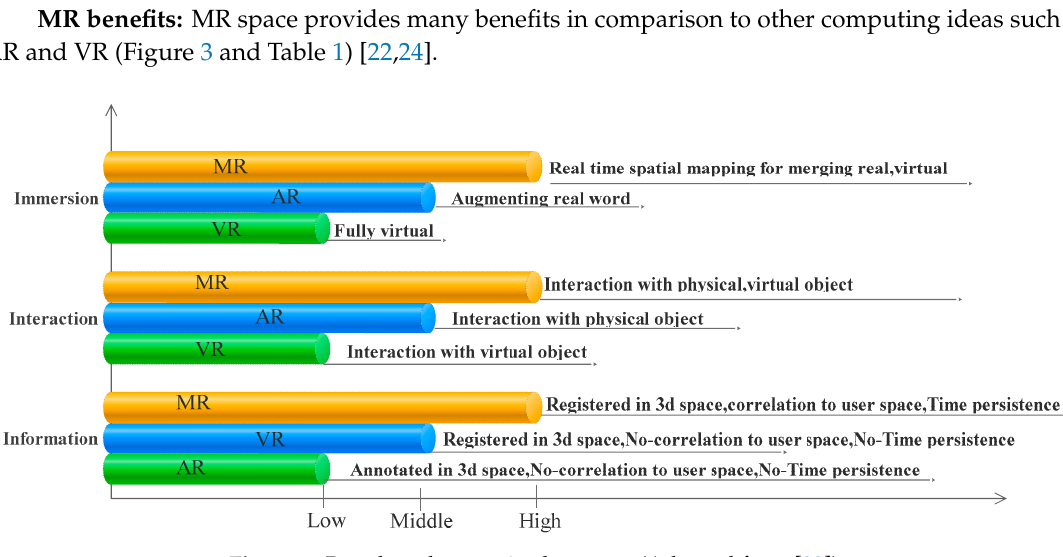
Figure 3. Based on three main characters (Adopted from [22]). Table 1. Comparison according to three key space specifications (Adopted from [24]).